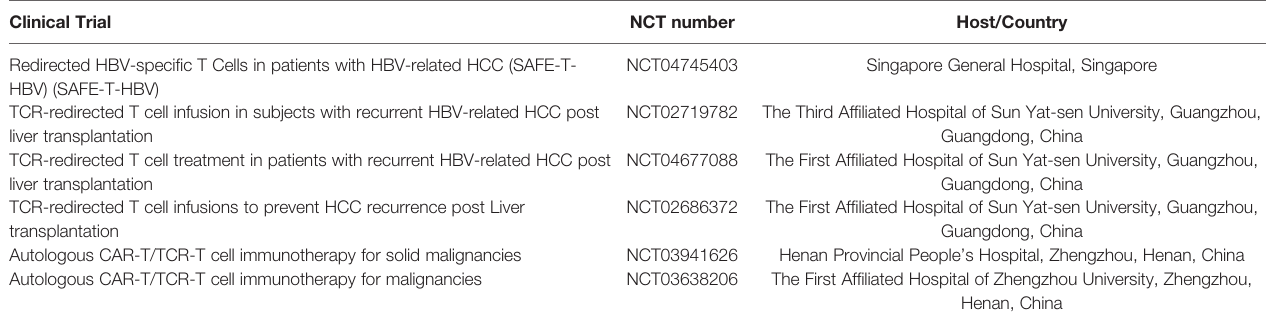
TABLE 1 | Recent clinical trials related to TCR-T cells for the treatment of HCC. Clinical Trial